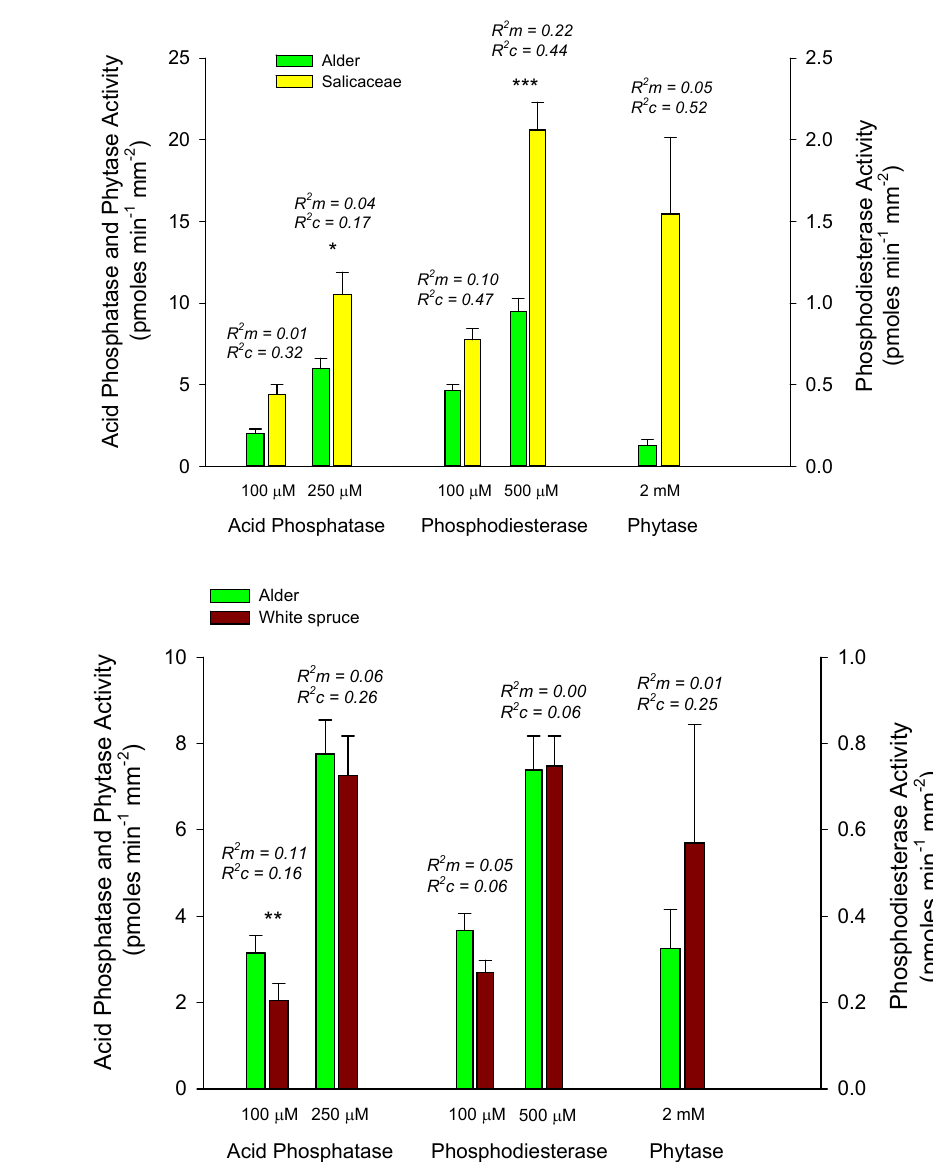
Figure 2. Comparison of mean ± S.E. activities of acid phosphatase, phosphodiesterase and phytase of alder root tips with Salicaceae root tips in early succession ( a ), and with white spruce root tips in late succession ( b ). Significant di ff erences between hosts are indicated above bars at p < 0.10 (*), 0.05 (**), and 0.01 (***). Marginal ( R 2 m ) and conditional ( R 2 c ) values generated for linear mixed e ff ects models evaluate variance explained by fixed and fixed + random e ff ects, respectively (see Statistics section above).